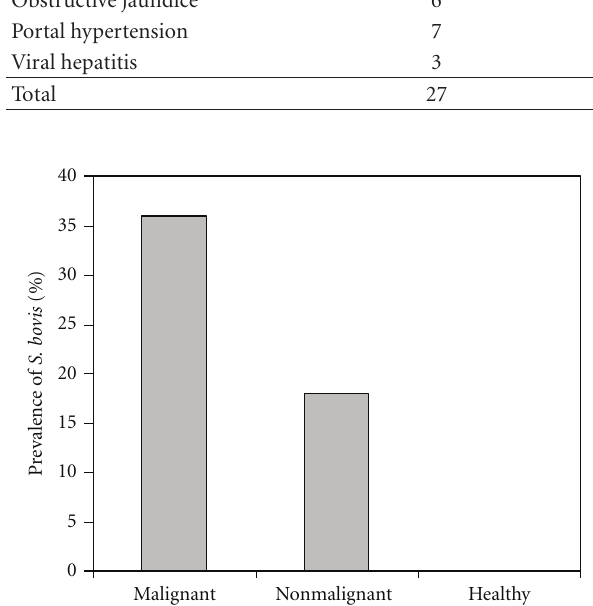
Figure 1: Prevalence of S. bovis in stool from the patients with malignant and non-malignant gastrointestinal diseases and healthy